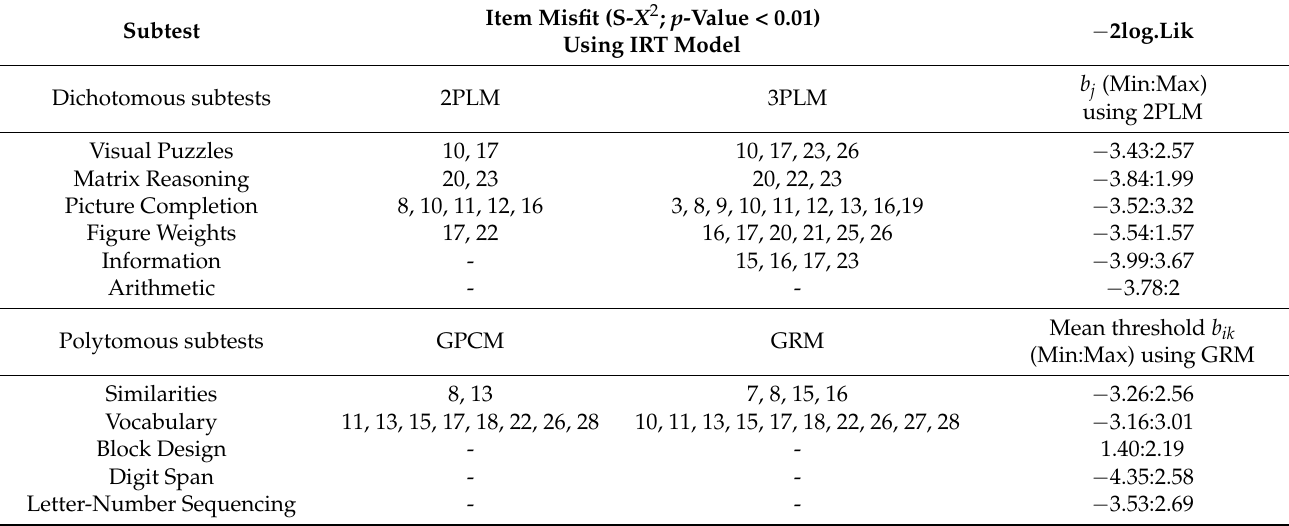
Table 5. Item misfit to IRT models, and range of difficulty parameter values for each subtest of the